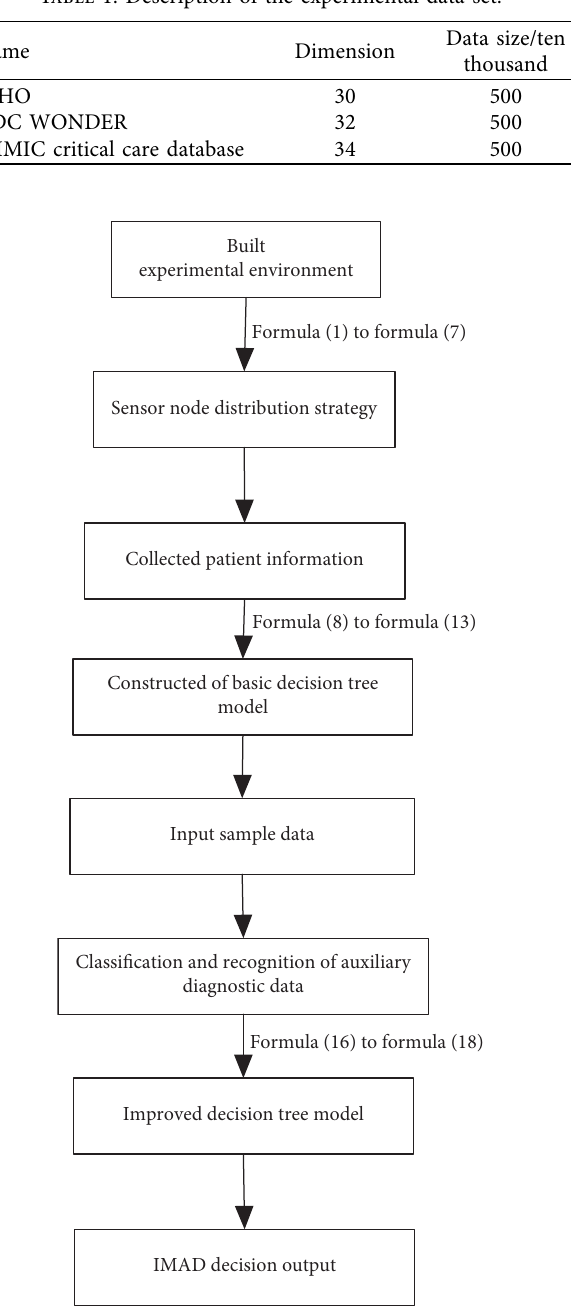
Figure 3: Algorithm verification